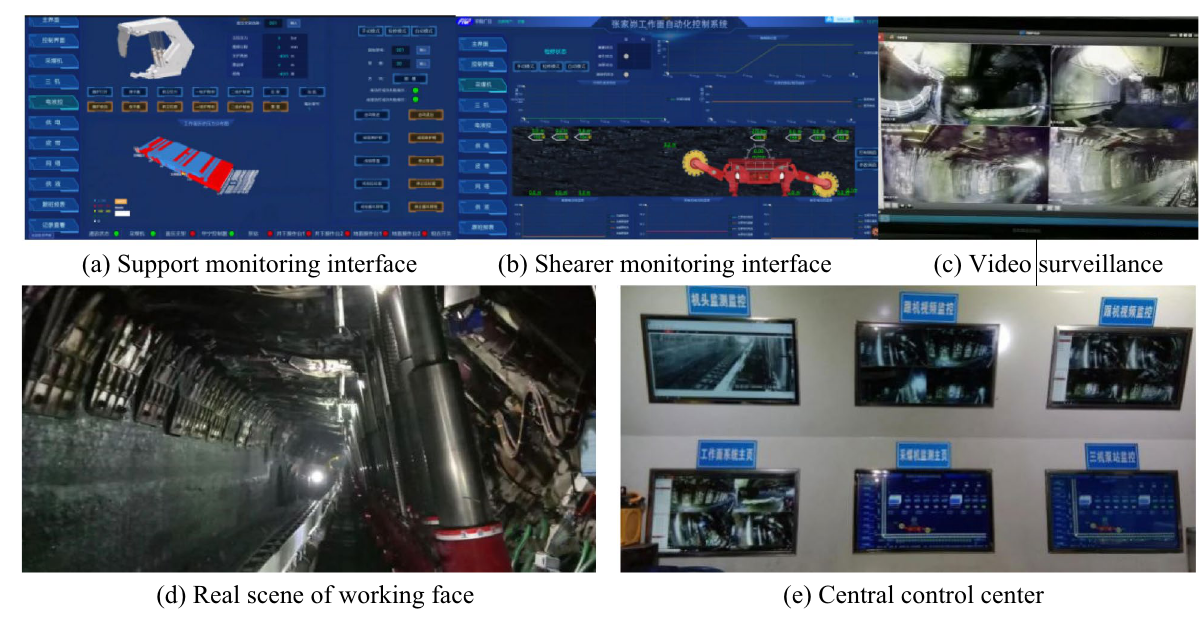
Fig. 3 Images and demand analysis from the demonstration working face